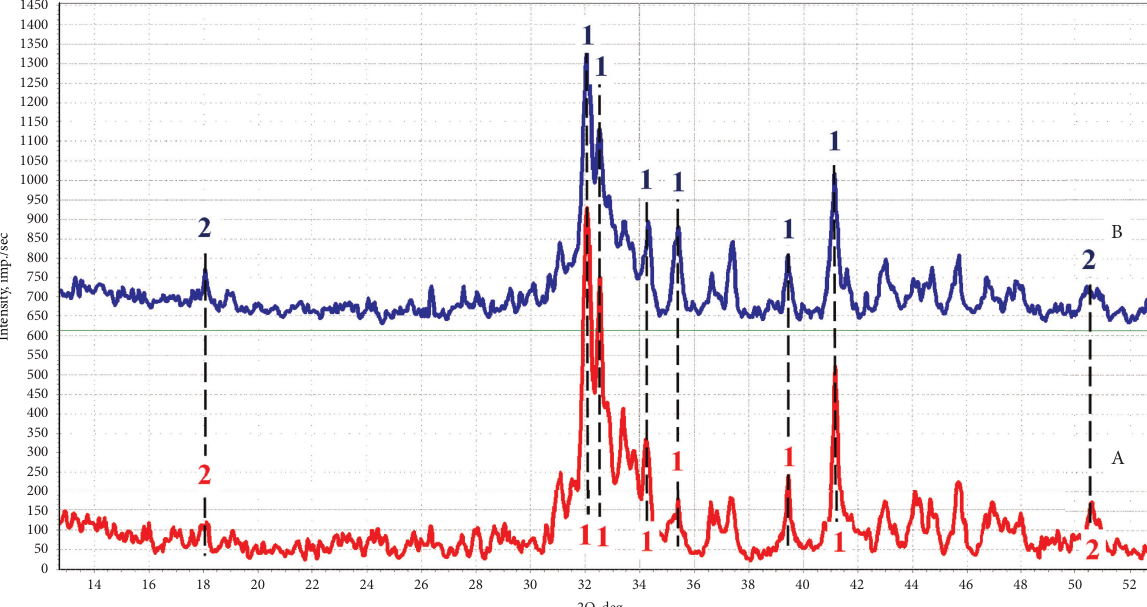
Figure 14: Diffraction patterns of cement paste (A) and cement paste in a composite based on a modified shot of titanium hydride (B), subjected to c -irradiation dose D � 10MGy: 1-Ca 2 SiO 4 ; 2-Ca(OH) 2